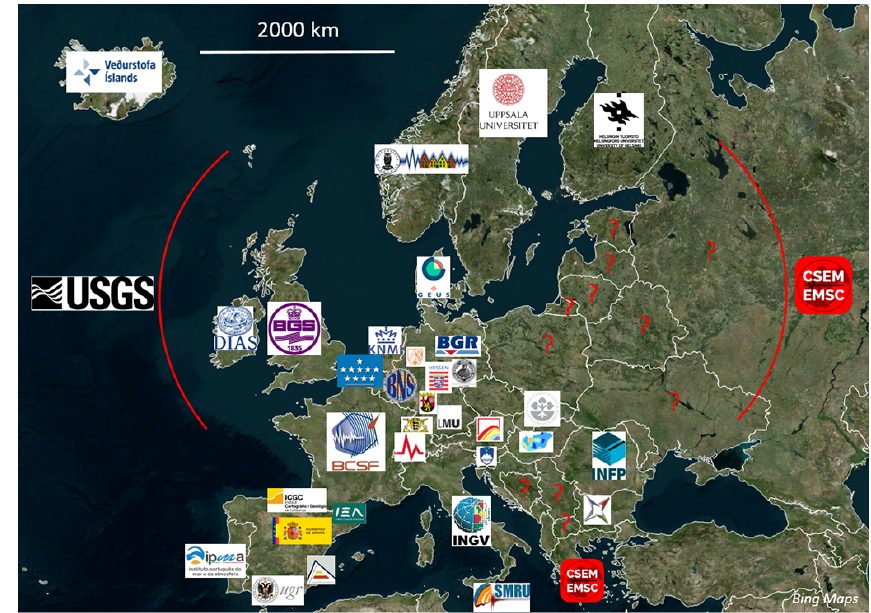
Figure 1. Overview of 33 European and 2 international (EMSC and USGS) seismological agencies that provide an online macroseismic questionnaire to gather witness reports about earthquakes felt throughout Europe. See Appendix A for institutional names and hyperlinks to the online questionnaires. Question marks indicate countries for which an online questionnaire is absent or has not been found